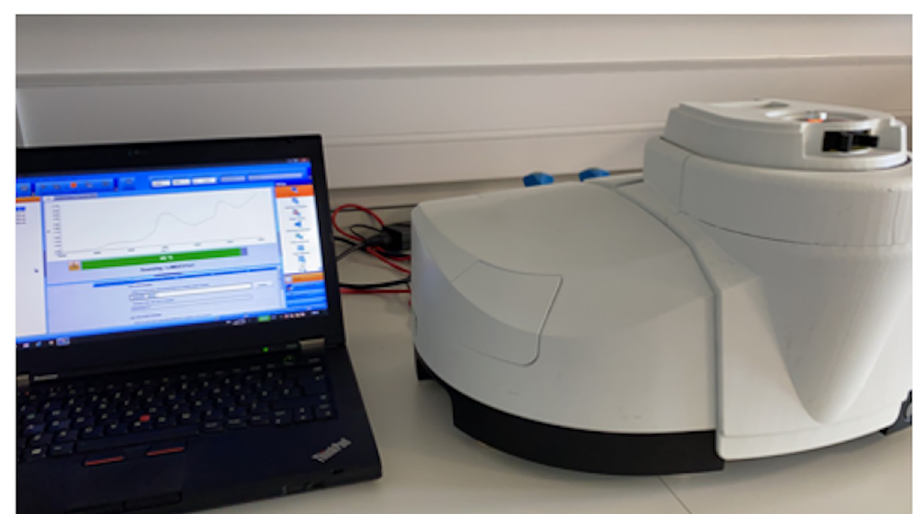
Fig 1. Perkin Elmer Spectrum Two NIR